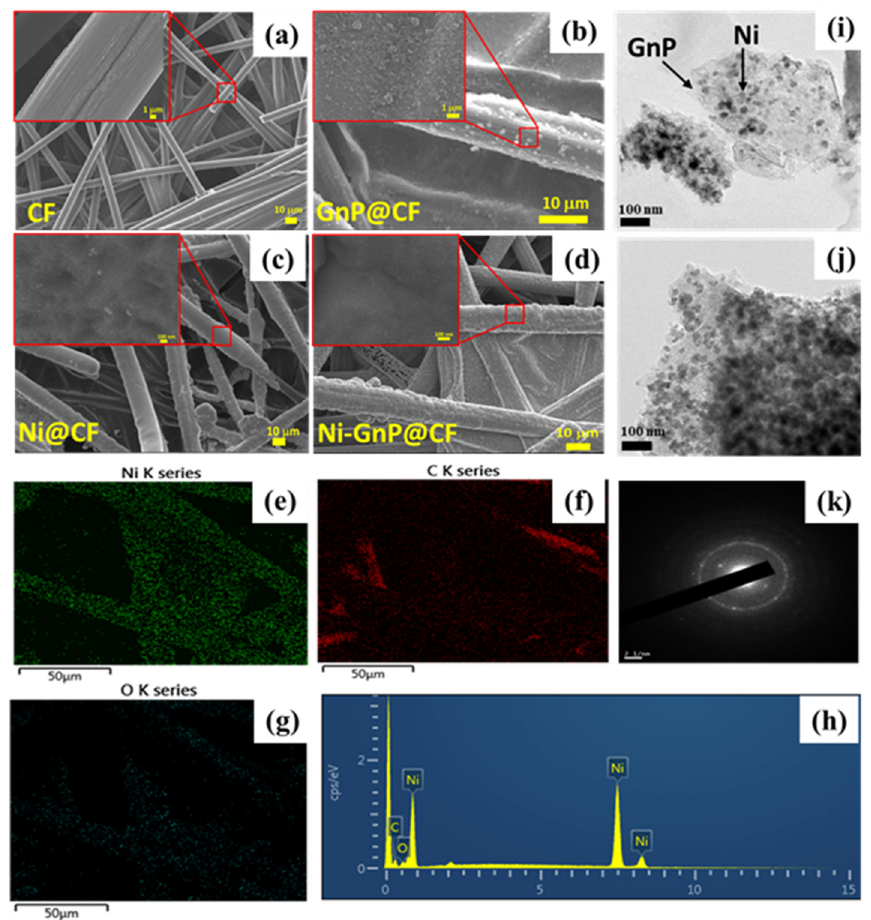
Figure 2. FESEM image of CF ( a ), GnP@CF ( b ), Ni@CF ( c ) Ni-GnP@CF ( d ); EDS mapping ( e – g ), EDS spectrum ( h ), TEM images ( i , j ), and SEAD pattern ( k ) of Ni-GnP@CF.